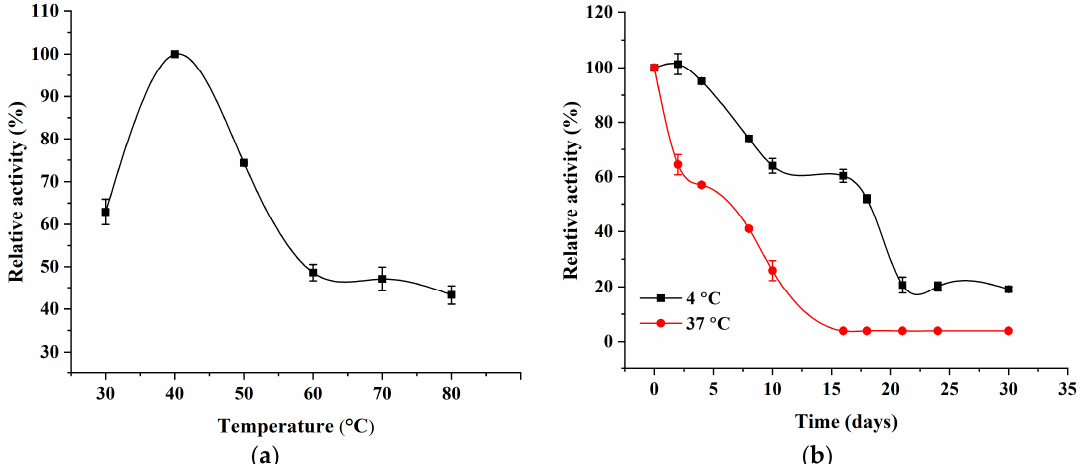
Figure 1. Effects of temperature on the activity ( a ) and time depended on stability at 4 ◦ C and 37 ◦ C ( b ) of soluble